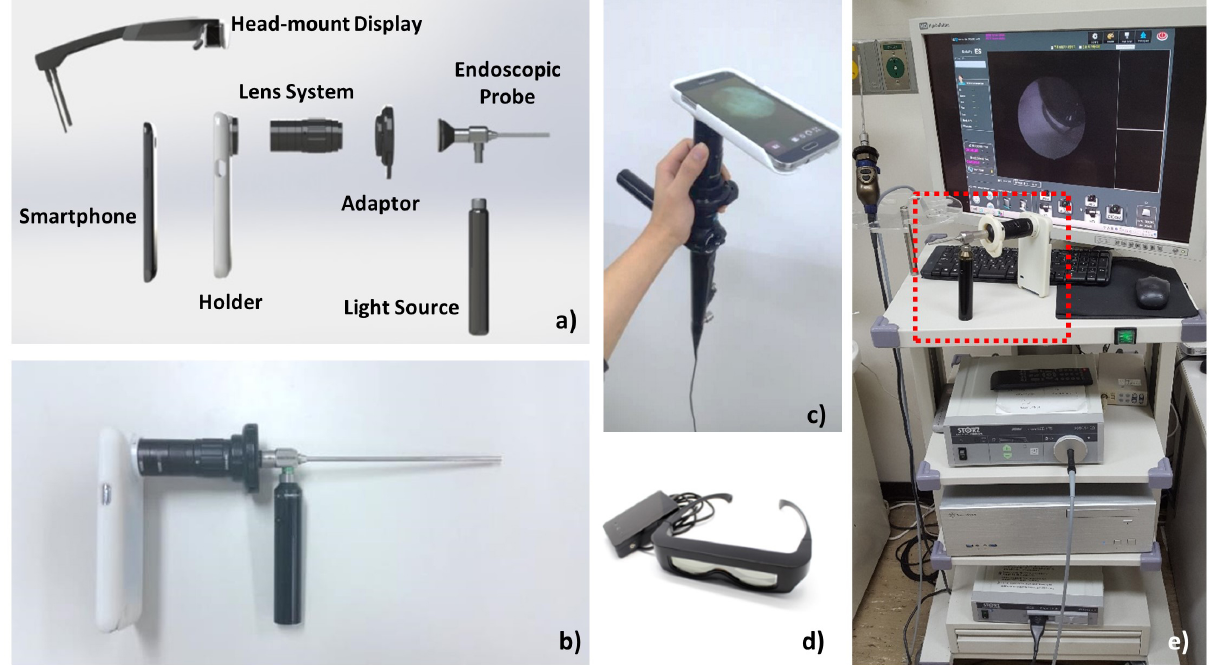
Figure 1. Smartphone-based endoscope system setup. (a) Schematic of smartphone-based endoscope system. A photography of (b) rigid type endoscopic system, (c) flexible type endoscopic system, (d) android based HMD, and (e) the smartphone-based endoscope system vs clinical endoscope